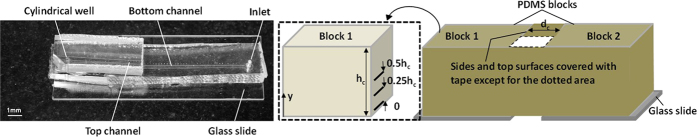
Photograph of the (a) proposed device (b) schematic showing the arrangement of PDMS blocks and (right) positions of the blood drops on the inner face of the block (right) for the contact angle studies.